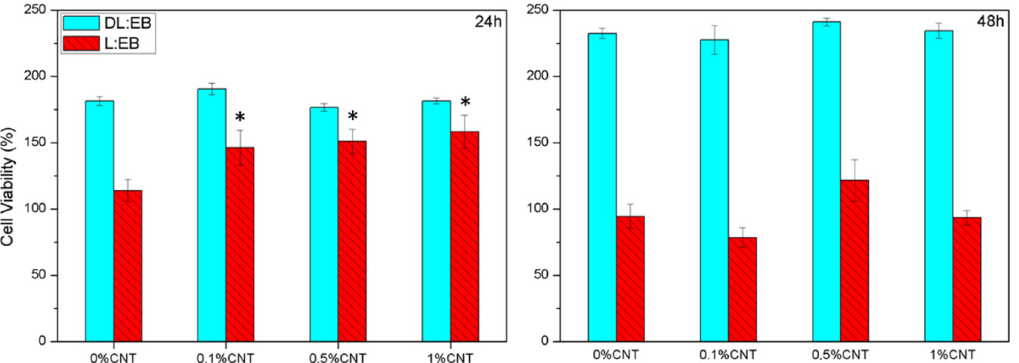
Figure 4. Metabolic activity of C8-D1A cells seeded on the studied samples after 24 h and 48 h. (* p < 0.05 compared to the sample not containing CNTs. Dunn´s method One-way ANOVA Analysis of Variance on Ranks); 100% metabolic activity was ascribed to C8-D1A cells seeded on the tissue culture plastic in the absence of our samples, and relative values were calculated for the rest of the samples.